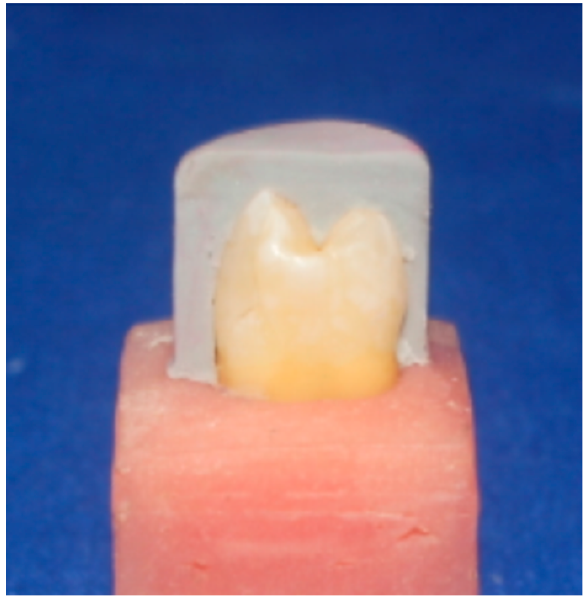
Figure 1. Silicone index made from condensation silicone.